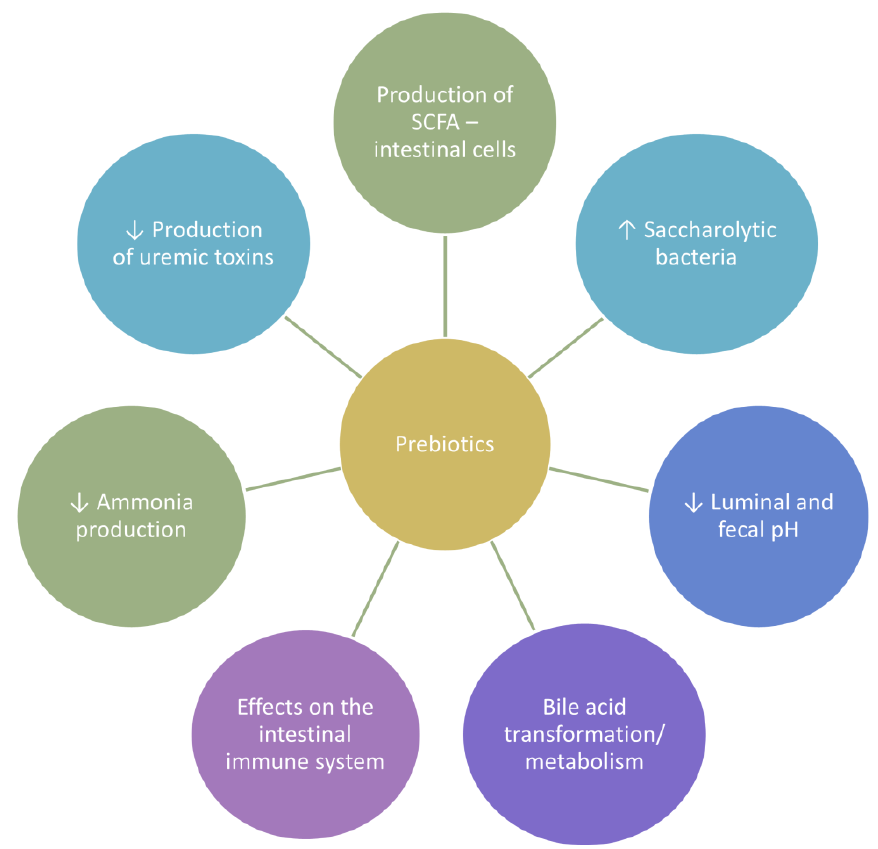
Figure 1. Beneficial effects of prebiotic fiber on the intestine. SCFA: short-chain fatty acids.